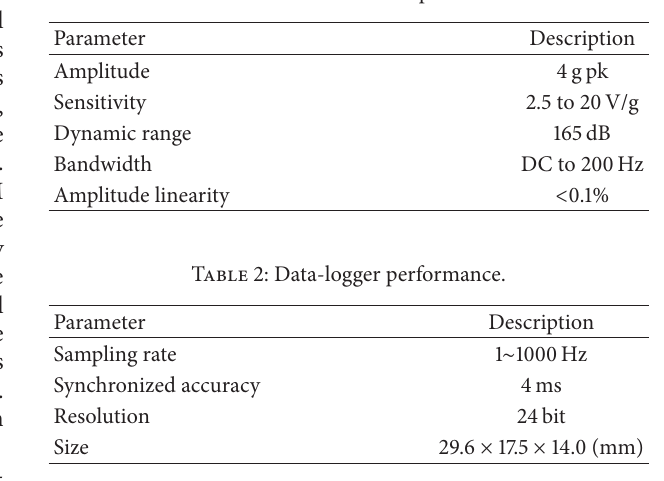
Table 1: Acceleration sensor performance.